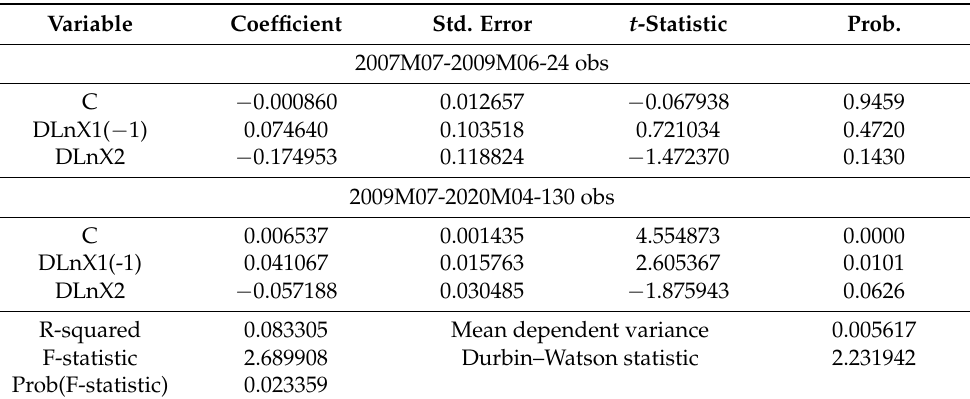
Table 3. Sample breakpoint: dependent variable: DLnY. Method: least squares with breaks. Sample (adjusted): 2007M07 to 2020M04. Included observations: 154 after adjustments. Break type: Fixed number of globally determined breaks. Break: 2009M07. Allow heterogeneous error distributions across